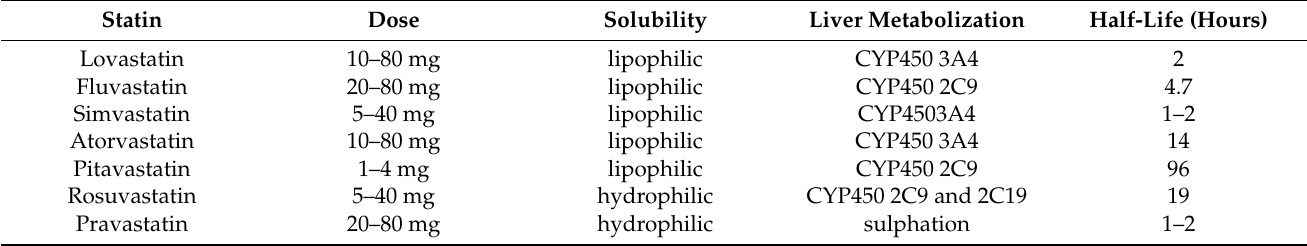
Table 1. Main characteristics of marketed statins.